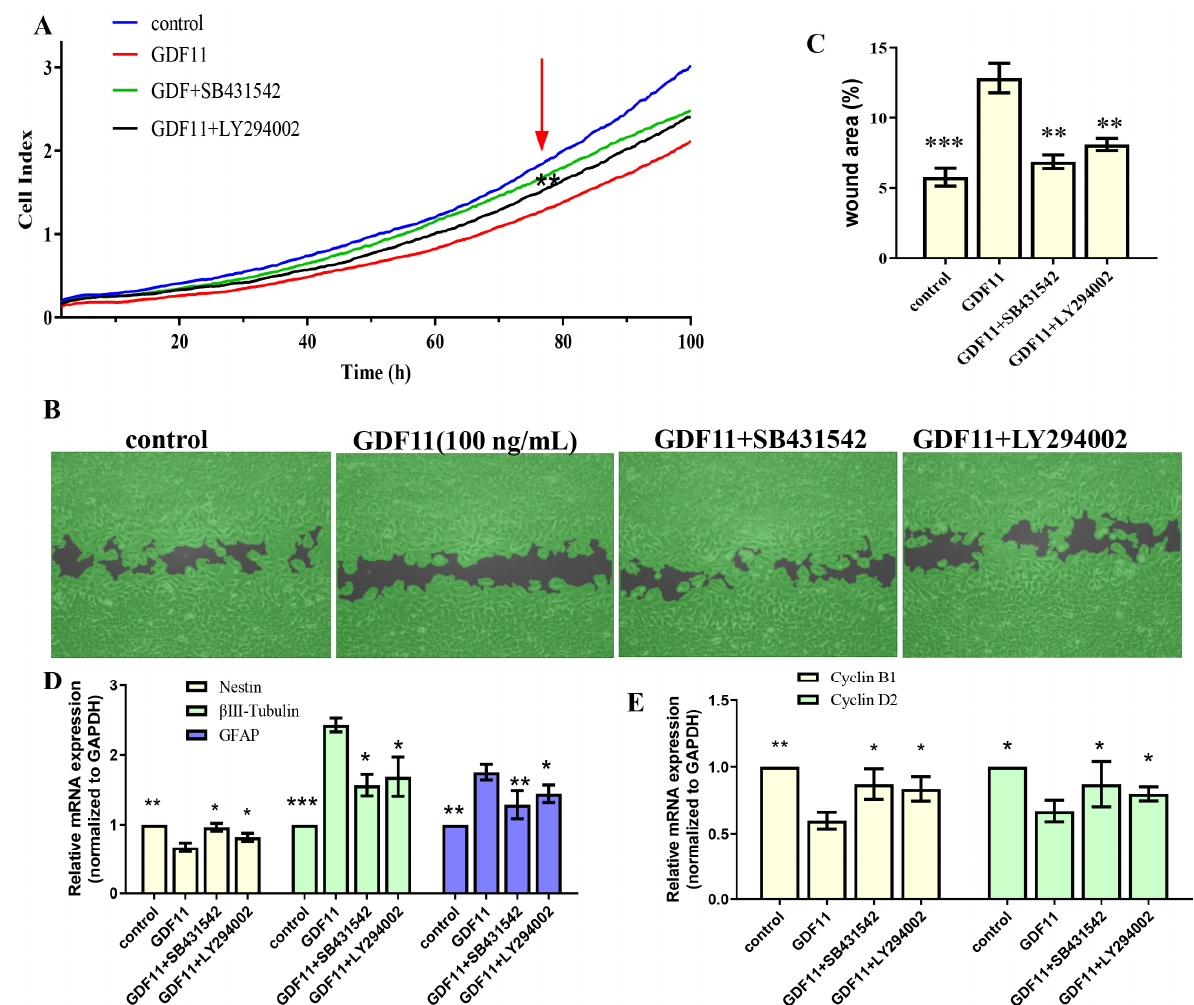
Figure 8. The effects of GDF11 on PC12 cell when ALK5 or PI3K were inhibited. ( A ) Proliferation of PC12 cells treated with GDF11 (100 ng/mL), SB431542 (20 μ M) or LY294002 (1 μ M) was assessed by RTCA. ( B ) SB431542 (20 μ M) or LY294002 (1 μ M) inhibited GDF11-induced suppression of migra- RTCA. ( B ) SB431542 (20 µ M) or LY294002 (1 µ M) inhibited GDF11-induced suppression of migration. tion. ( C ) Quantitative analysis of ( B ). ( D,E ) were the transcriptional levels of nestin, β III-tubulin, ( C ) Quantitative analysis of ( B ). ( D , E ) were the transcriptional levels of nestin, β III-tubulin, GFAP, GFAP, cyclin D2 and cyclin B1, respectively. * p < 0.05, ** p < 0.01, *** p < 0.001. cyclin D2 and cyclin B1, respectively. * p < 0.05, ** p < 0.01, *** p <